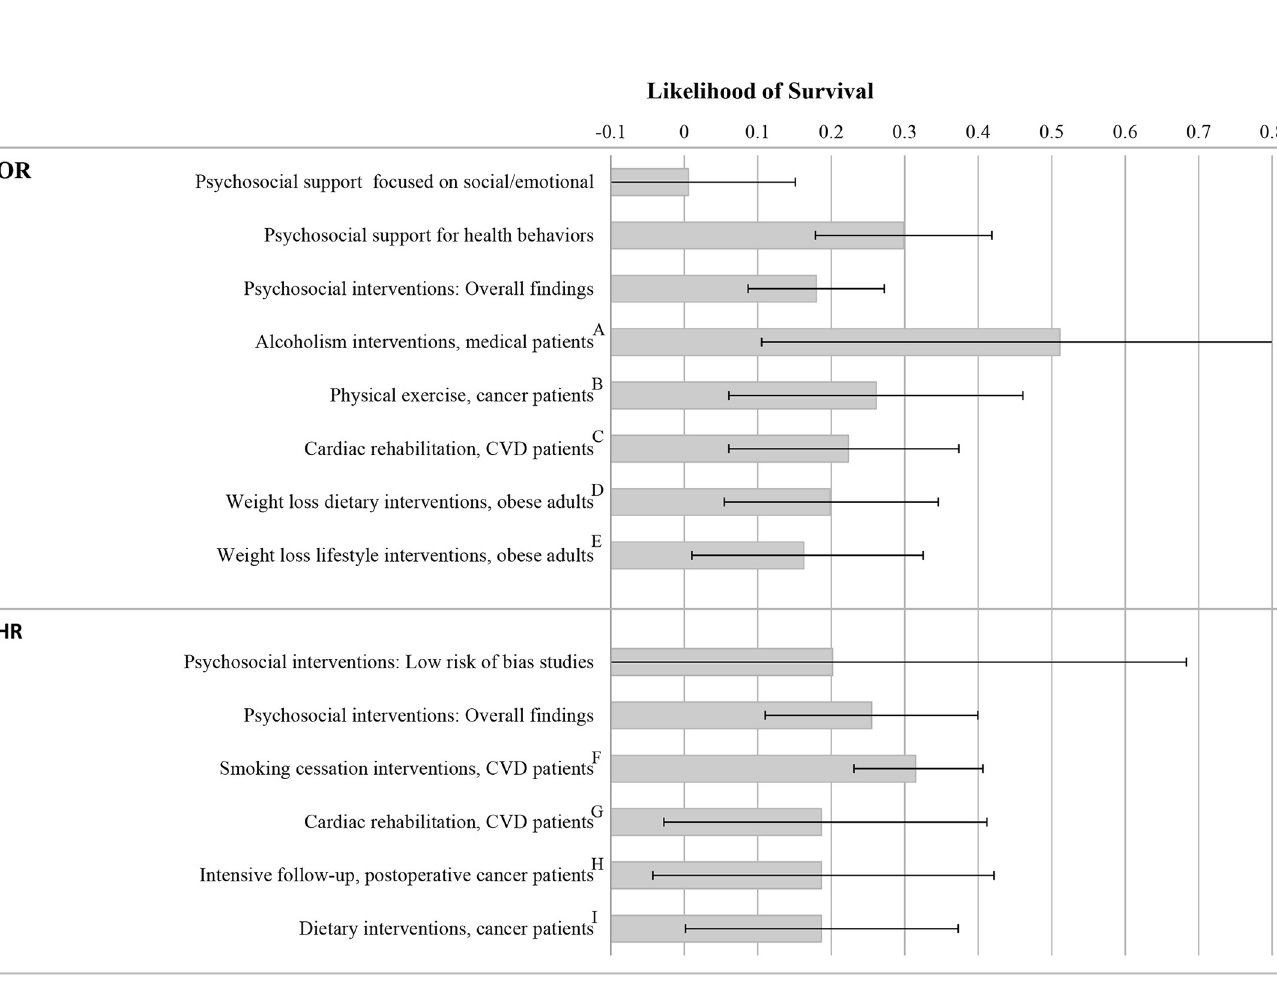
Fig 3. Comparison of odds (lnOR) and hazards (lnHR) of mortality across several tertiary prevention interventions. Note: lnOR = natural logarithm of the OR of patient survival. lnHR = natural logarithm of the HR of patient survival. Effect size of 0 indicates no effect, and values above 1 favor the intervention group relative to the control group. Comparison effect sizes and 95% confidence intervals were reported in meta-analyses: A = McQueen et al. [149]; B = Wu et al. [150]; C = Taylor et al. [151]; D = Ma et al. [152]; E = Kritchevsky et al. [153]; F = Mons et al. [154]; G = Taylor et al. [155]; H = Calman et al. [156]; I = Hauner et al. [157]. CVD, cardiovascular disease; HR, hazard ratio; OR, odds